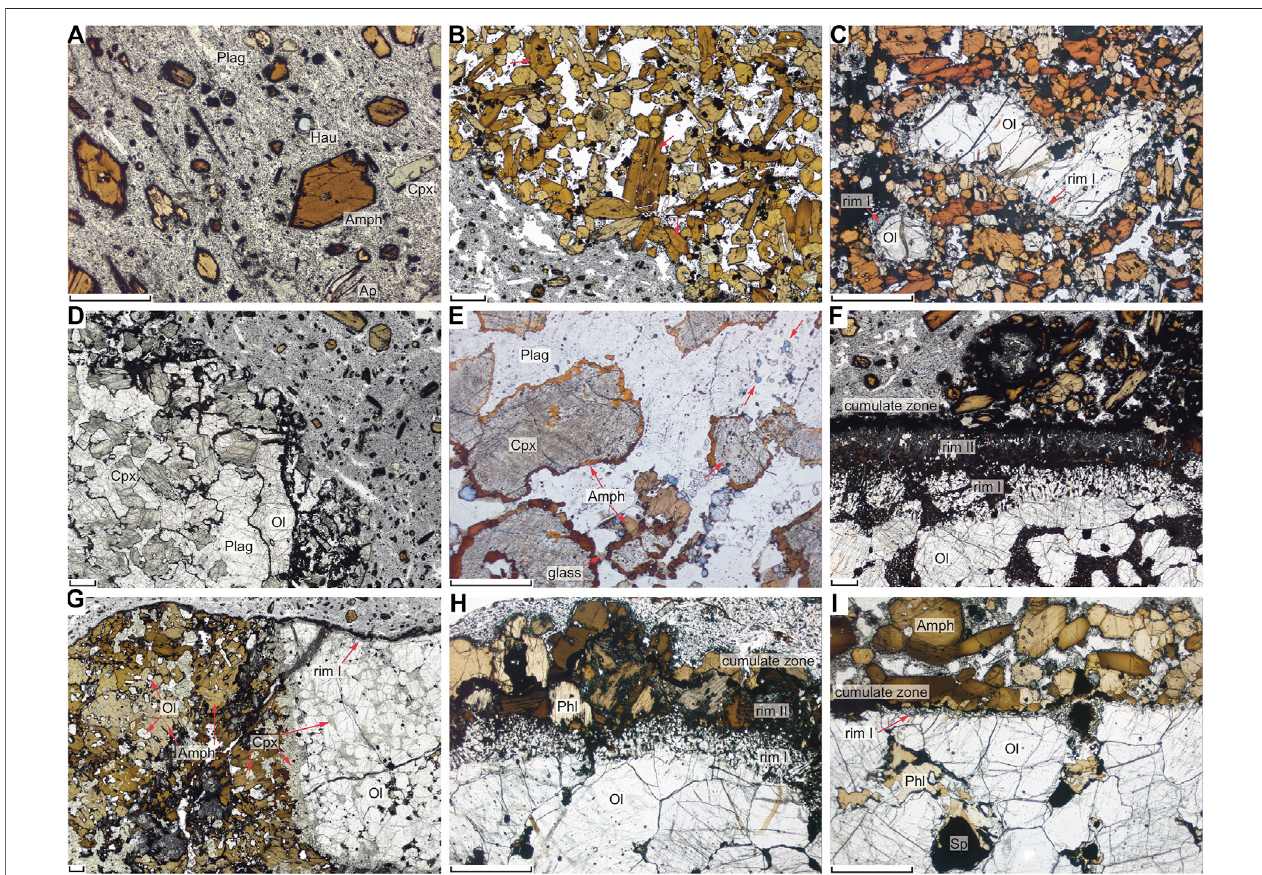
FIGURE 2 | Microphotographs from selected samples taken at plane polarized light; scale bars are 1 mm. Abbreviations: Cpx, clinopyroxene; Amph, amphibole; Plag, plagioclase; Ol, olivine; Phl, phlogopite; Sp, spinel; Ap, apatite; Hau, haüyne. (A) Sample KLA1718: tephriphonolite with kaersutite, clinopyroxene, plagioclase, haüyne,andapatitemacrocrysts. (B) SampleKLA1705:kaersutite-dominatedcumulatexenolithwithopentexture;hosttephriphonolitetothelowerleft.Arrowsindicate examplesofstronglyzonedcrystals. (C) SampleKLA1709:olivineandsmallperidotitefragmentwithreactionrimofCpx+Mtwithinkaersutite-dominatedcumulate xenolith. (D) Sample KLA1701: olivine gabbro xenolith with incipient melting at grain boundaries; degree of melting increases towards the host tephriphonolite contact (upper right). (E) Sample KLA1708: strongly metasomatized gabbro xenolith with blue haüyne and brown amphibolearound clinopyroxene. Note the presence ofglass, euhedral Amph, euhedral haüyne within newly crystallized Plag, and recrystallized Cpx along a NE-SW trending vein (arrows). (F) Sample KLA1704: spinel wehrlite xenolith (bottom) with cumulus texture and Cpx that is in large parts replaced by opaque Phl-rich aggregates. The xenolith has a prominent selvage towards the host tephriphonolite (top) consisting of Cpx-Mt-dominated rim I, Phl-dominated rim II, and Amph-rich cumulate zone. (G) Sample KLA1735: composite xenolith with veined wehrlite (right) and cumulate dominated by brown Amph oikocrysts, subhedral Ol, and Cpx (left). The wehrlite has a thick Cpx-Mt selvage towards the cumulate, and a thinselvagetowardsthehosttephriphonolite(top). (H) SampleKLA1731:dunitexenolith(bottom)withselvageconsistingofCpx-Mt-dominatedrimI,Phl-dominatedrim II, and Amph-rich cumulate zone. (I) Sample KLA1721: peridotite xenolith (bottom) with metasomatic Phl and two-part selvage, consisting of a narrow Cpx+Mt dominated reaction rim I and an Amph-dominated cumulate zone; rim II is absent in this sample.